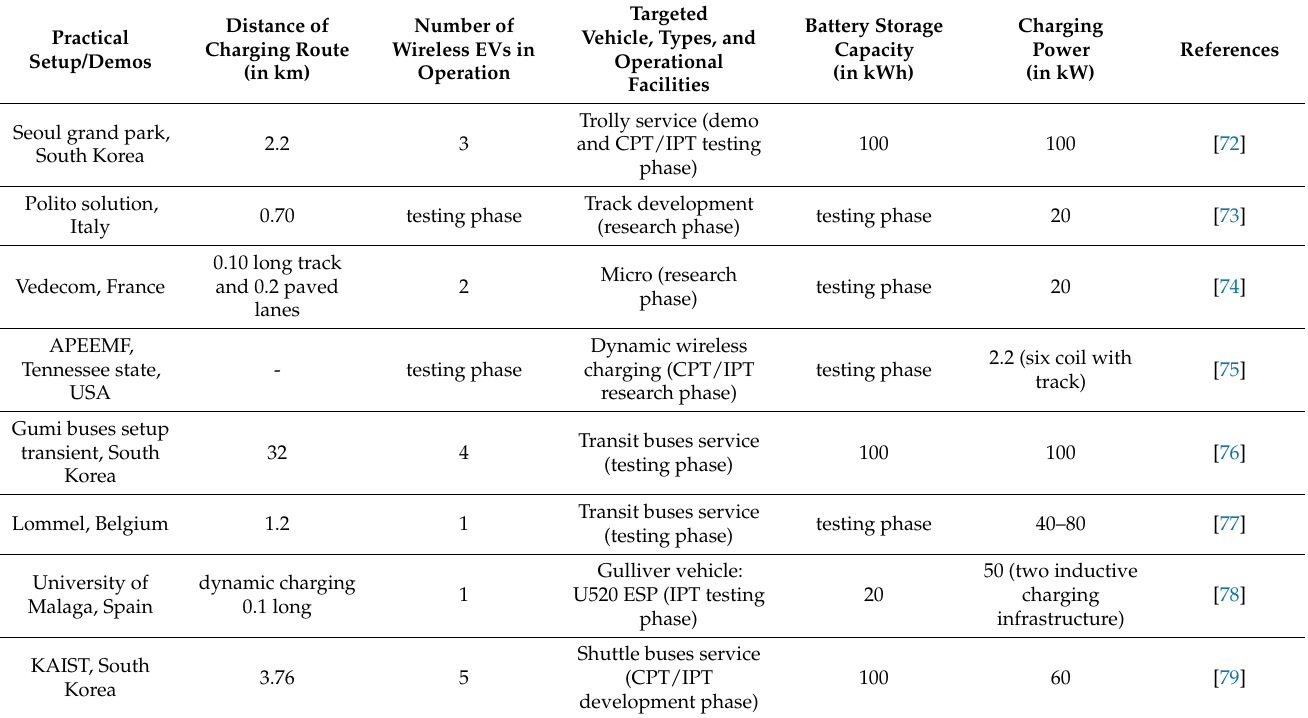
Table 3. Practical allocation of wireless EV charging